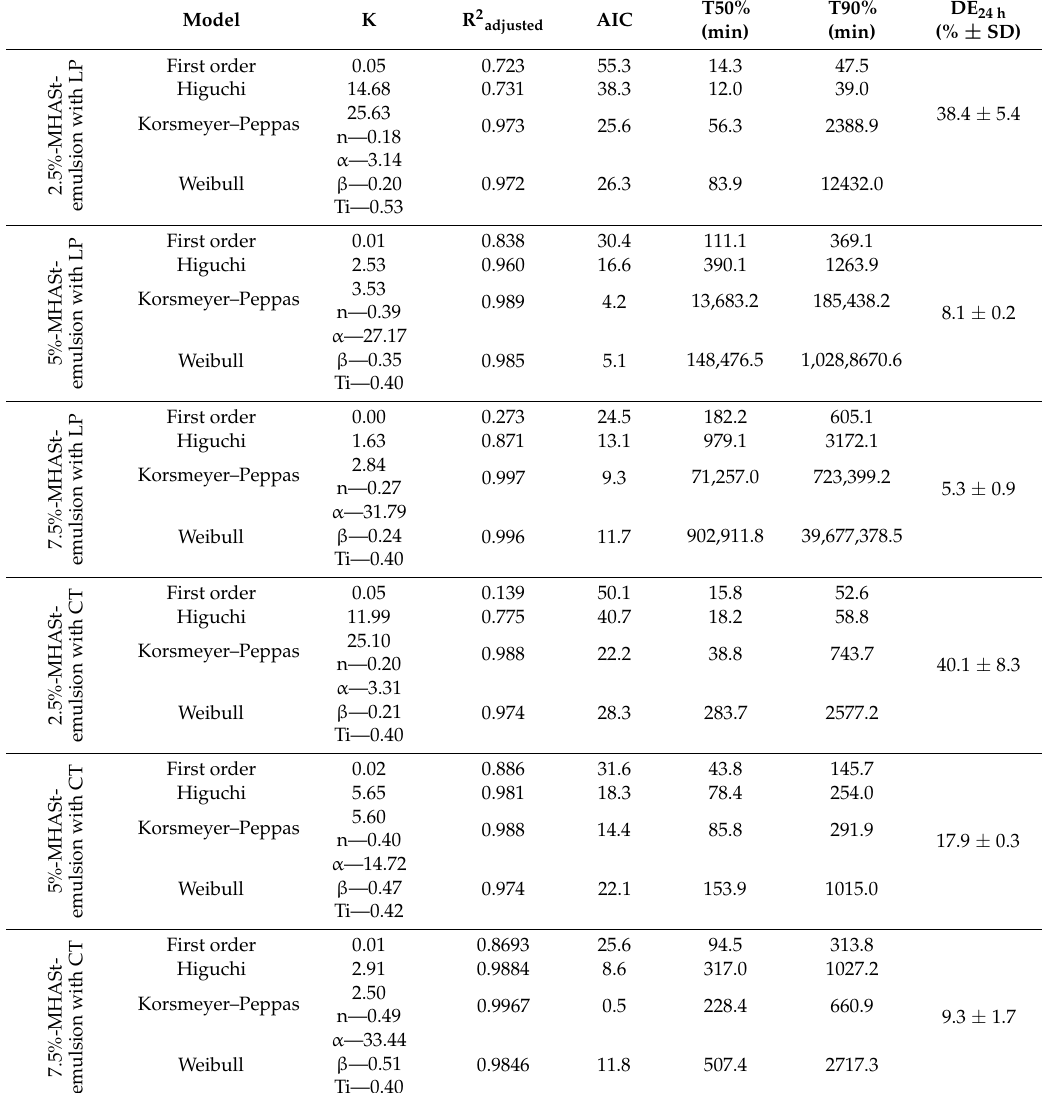
Table 2. Kinetic parameters obtained after fitting the release data from the MHASt-emulsions with LP and CT to different release models (mean ± standard deviation (SD), n =